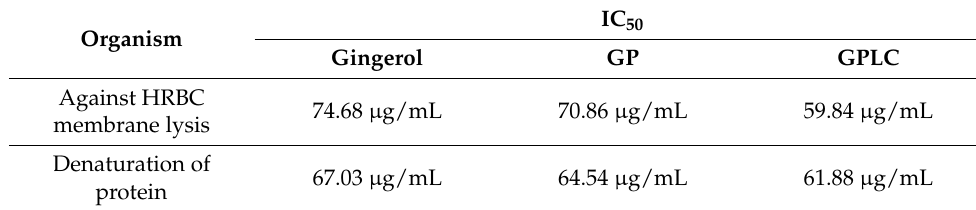
Table 6. In vitro anti-inflammatory effect